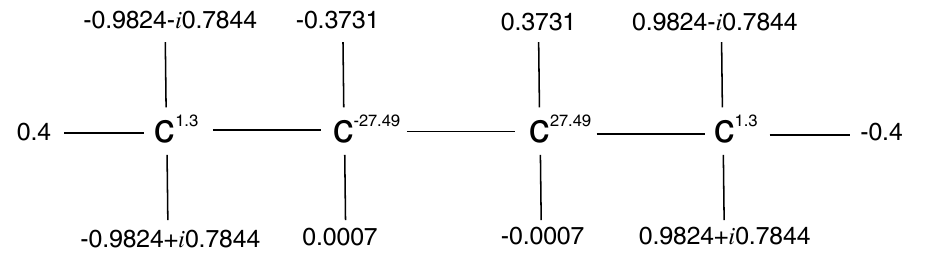
Figure 9. Artificial hydrocarbon network structure.